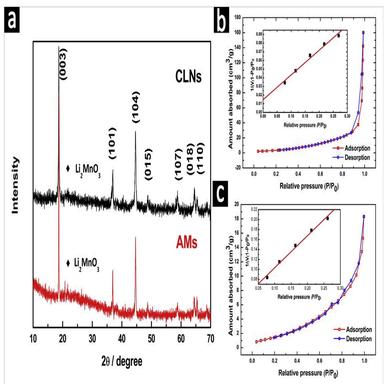
SAED patterns of Li1.2Ni0.15Co0.1Mn0.55O2 (a) CLNs and (b) AMs.